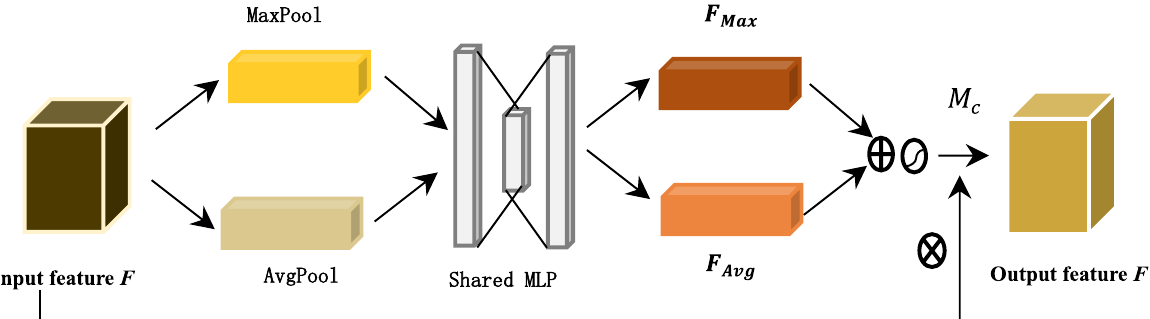
Fig. 4 The basic structure of the spatial attention